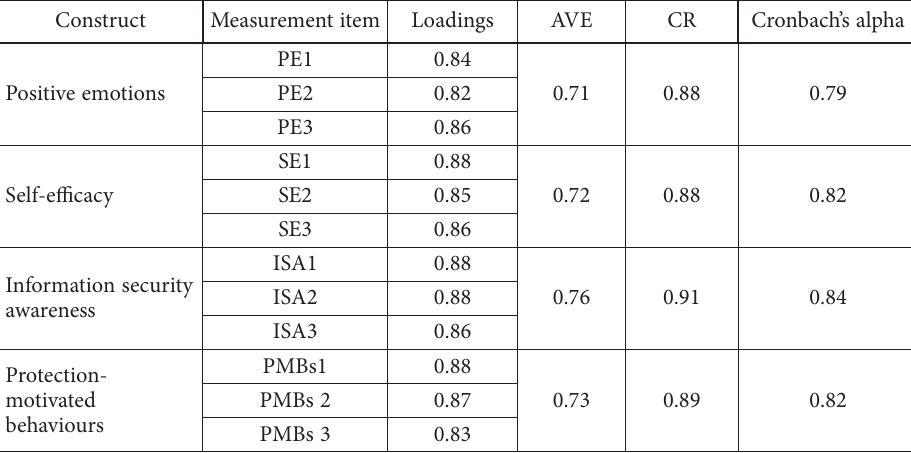
Table 2. Loadings, CR, and AVE of measurement items